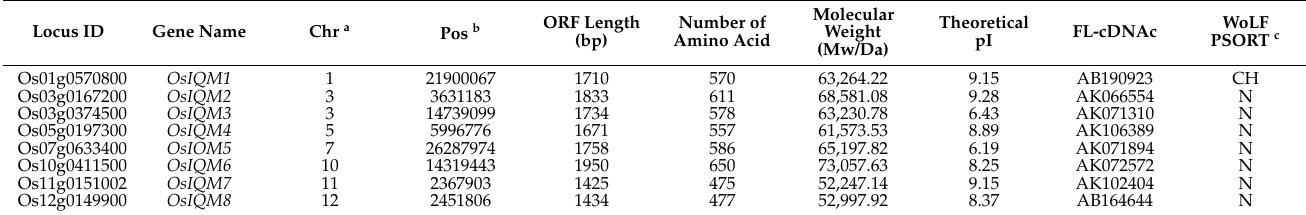
Table 1. Eight identified members of the rice IQM gene